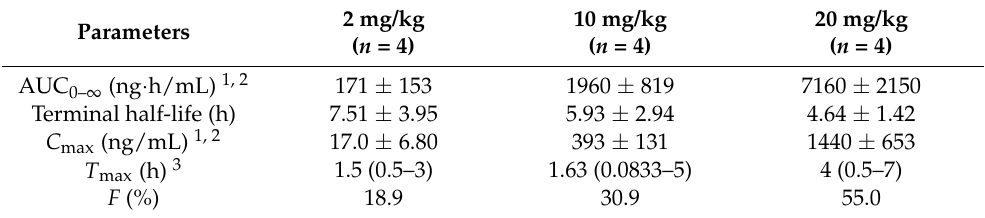
Table 3. Pharmacokinetic parameters (mean ± S.D.) for DA-6886 after single oral administration at doses of 2, 10, and 20 mg/kg to